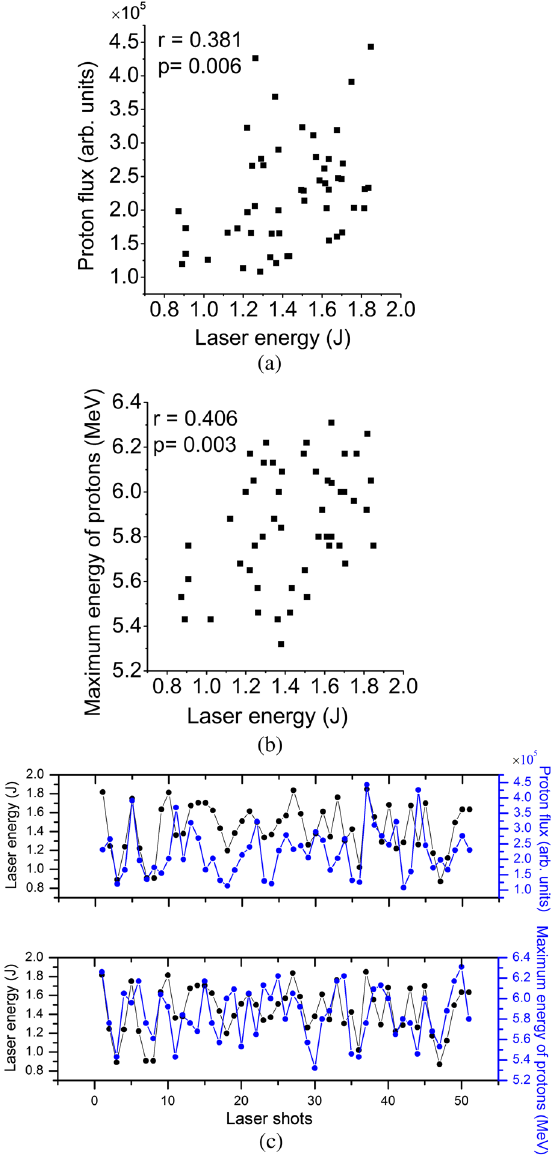
6. The correlation scatter plots and Pearson correlation coefficient values of proton beam parameters versus laser energy. (a) proton flux, (b) protons maximum energy, and (c) trend of laser energy and proton beam parameters for fifty